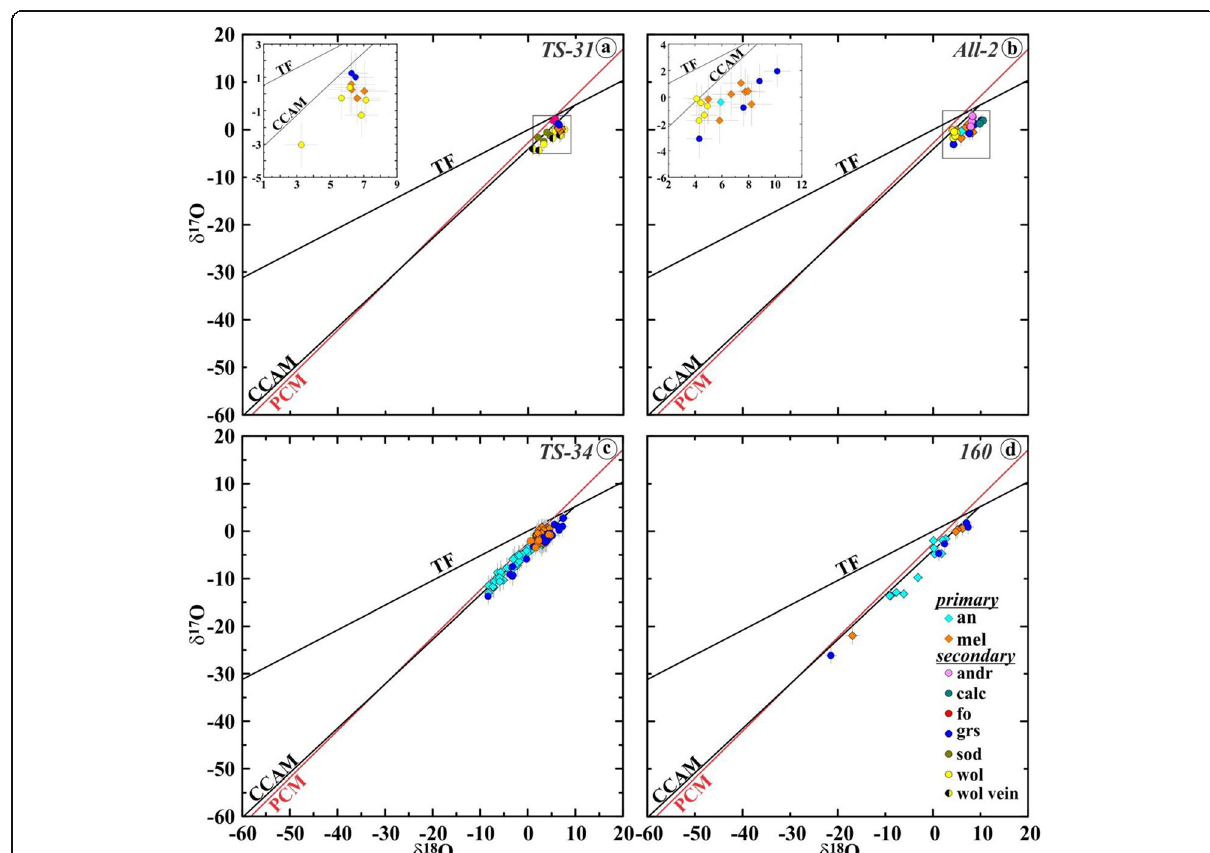
Fig. 21 Three-isotope oxygen diagrams on primary melilite and anorthite, and secondary andradite, calcite, grossular, sodalite, and wollastonite in the Allende CAIs TS-31 (B2), All-2 (FoB), TS-34 (B1), and 160 (C). Grossular and wollastonite (yellow circles) replace melilite and appear to have formed contemporaneously. Andradite, calcite, and wollastonite in veins (black-and-yellow circles) crosscutting the grossular±wollastonite-bearing assemblages precipitated directly from aqueous solutions. Primary melilite and anorthite are 16 O-depleted relative to spinel, Al,Ti-diopside (except TS-34 ), and forsterite; melilite is more 16 O-depleted than anorthite. Secondary minerals have similar compositions to those of anorthite and melilite. In TS-31 and All-2 , secondary minerals plot along mass-dependent fractionation line slightly below the TF line ( Δ 17 O ~ − 3 ‰ ). Insets in “ a ” and “ b ” show O-isotope compositions of grossular and wollastonite that appear to have formed contemporaneously by replacing primary melilite; there is a small range of δ 18 O between these secondary minerals, 4 and 6 ‰ in TS-31 and All-2 , respectively. In TS-34 and 160 , secondary grossular together with primary melilite and anorthite plot along CCAM